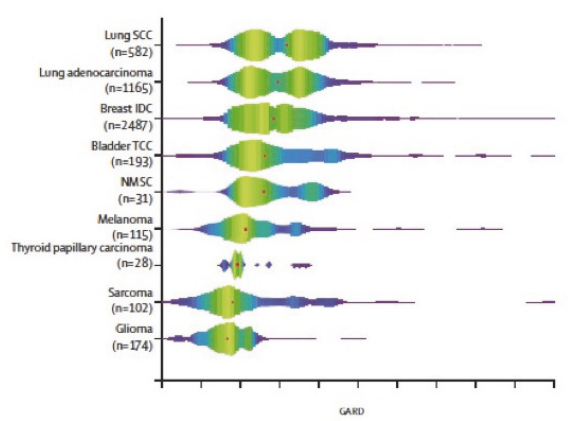
Figure 2: GARD score distribution and density within 60 Gy dose level, by disease site. The red dot represents the median GARD value for each disease site at assigned dose levels. Colors in the plot correlate with the sample density. GARD=genomic adjusted radiation dose. IDC=invasive ductal carcinoma. TCC=transitional cell carcinoma. NMSC=nonmelanoma skin cancer. Reprinted from The Lancet Oncology , Vol. 18, Scott JG, Berglund A, Schell MJ et al., A genome-based model for adjusting radiotherapy dose (GARD): a retrospective, cohort-based study, 202-211, 2017, with permission from